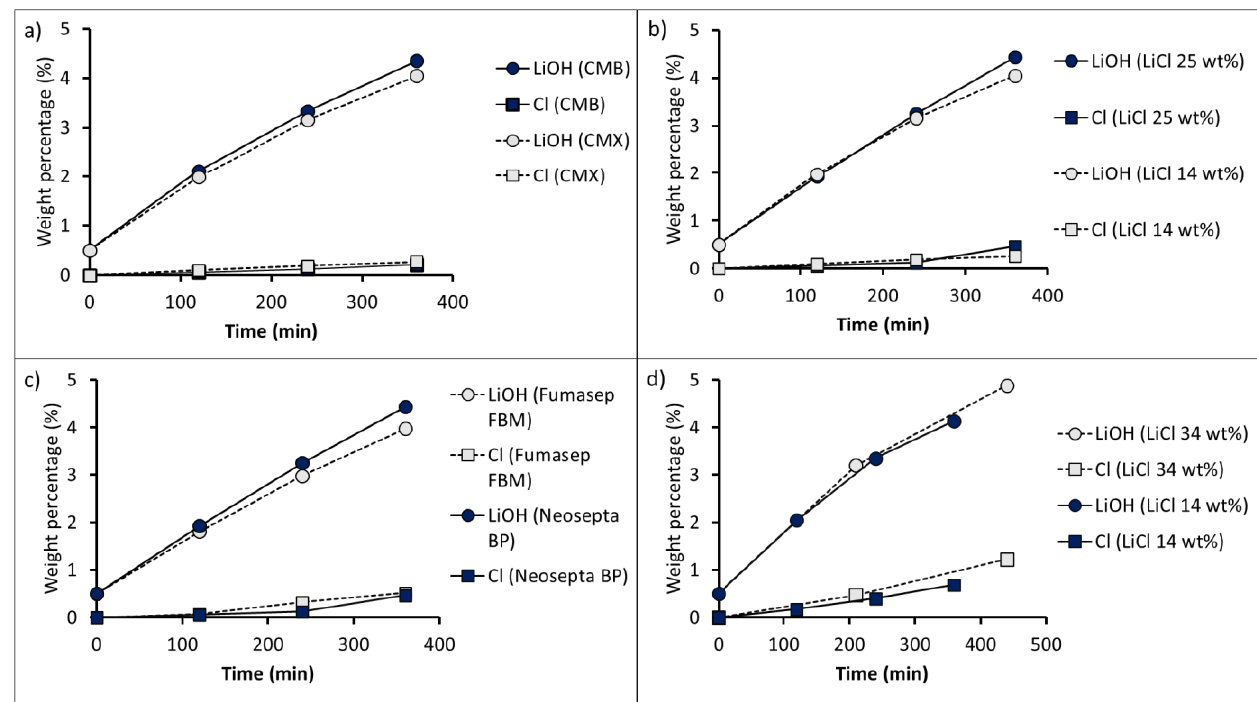
Figure 10. Concentration variation of LiOH and Cl − in LiOH solution according to different operating conditions: ( a ) com- parison of the cation-exchange membranes CMX and CMB (Test 1 and Test 2); ( b ) comparison of 14 and 25 wt% LiCl concentrations at 1000 A∙m − 2 (Test 1 and Test 3); ( c ) comparison of the bipolar membranes Neosepta BP and Fumasep FBM (Test 3 and Test 4); ( d ) comparison of 14 and 34 wt% LiCl concentrations at 500 A∙m − 2 (Test 5 and Test 6). Initial LiOH concentration 0.5 wt%.